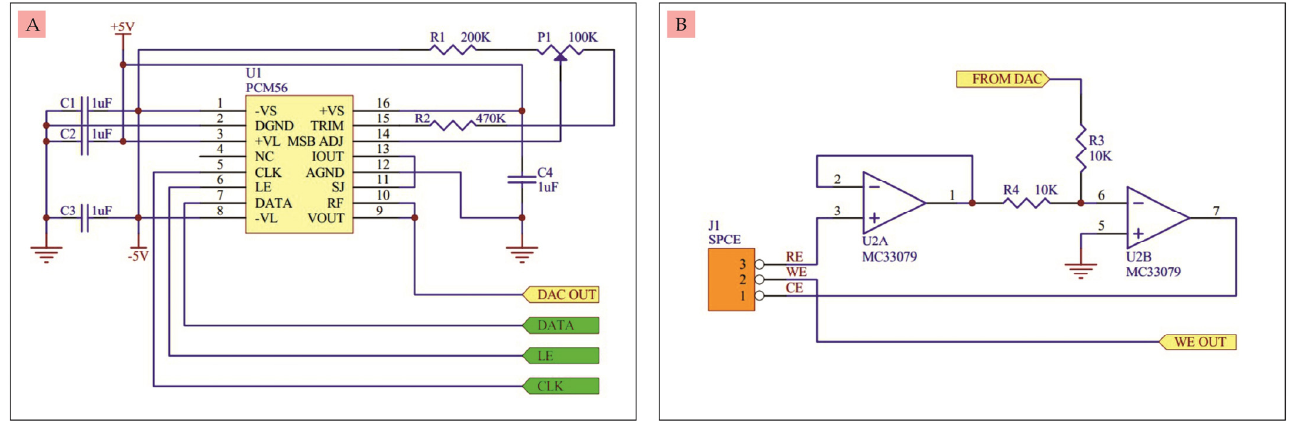
Figure 2. ( A ) 16-bit DAC circuit, ( B ) Buffer and differential amplifier